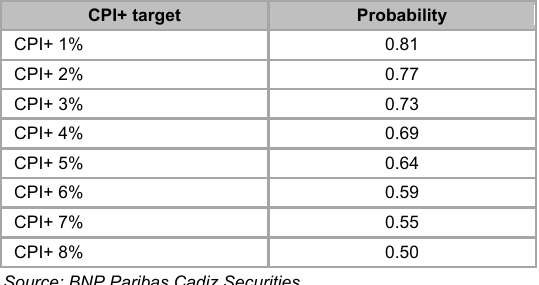
Probability of achieving various absolute return targets over 3 year rolling horizons (January 1971 to December